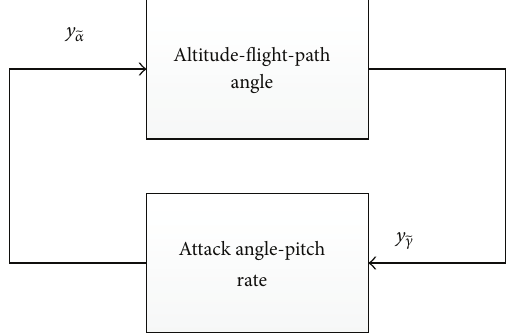
Figure 1: Interconnection subsystem